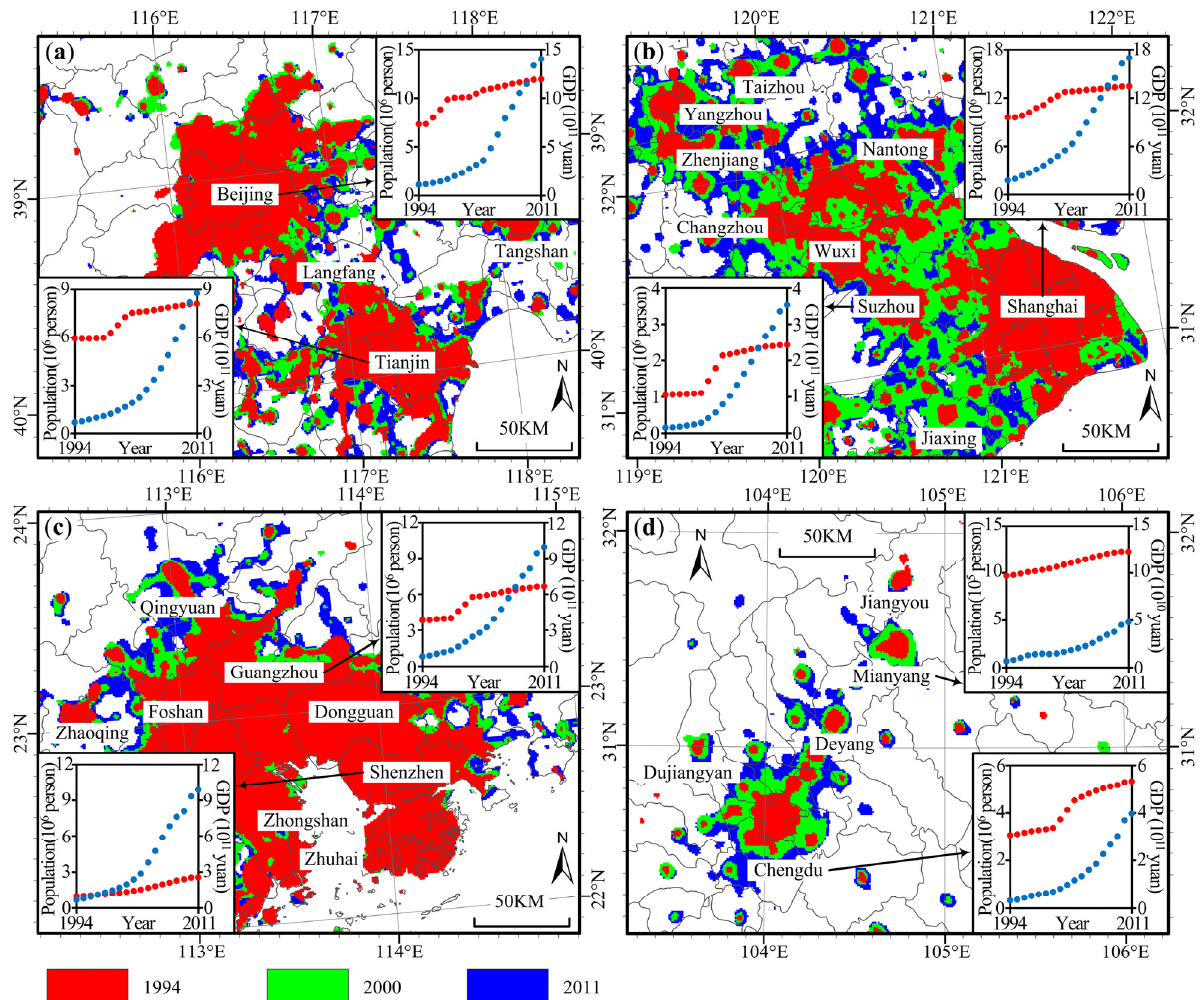
Figure 2. Spatio-temporal dynamics in the Defense Meteorological Satellite Program’s Operational Linescan System (DMSP/OLS) night light area and statistical data trends for China’s cities located in 4 major metropolitan areas between 1994 (red), 2000 (green) and 2011 (blue): ( a ) Beijing-Tianjin area; ( b ) Yangtze River Delta; ( c ) Perl River Delta; ( d ) Sichuan province. Solid curves are administrative